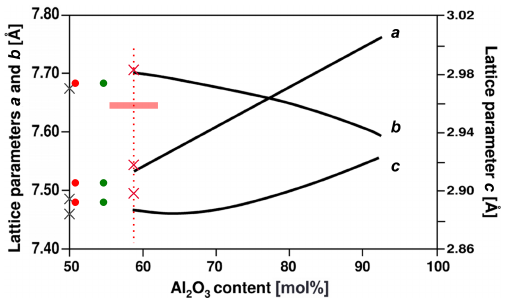
Figure 7. Lattice parameters plotted versus Al 2 O 3 concentration of the mullite compositional series Al 2 [ Al 2 + 2 x Si 2 − 2 x ] O 10 − x , modi- fied plot after Fischer et al. (1996). The left ordinate refers to lattice parameters a and b , and the right one refers to c . Red crosses dis- play lattice parameters of mullite-2 c for the chemical composition of the EMPA. Red and green dots represent lattice parameters from Fischer et al. (2015) for a composition derived from EMPA (red) and single-crystal-structure refinement (green), respectively. Grey crosses show lattice parameters of sillimanite (Burnham, 1963). Fe 2 O 3 is assigned to the Al 2 O 3 content. The horizontal red bar rep- resents the standard deviation of the microprobe composition. For comparison with mullite the c parameter of mullite-2 c and silliman- ite is